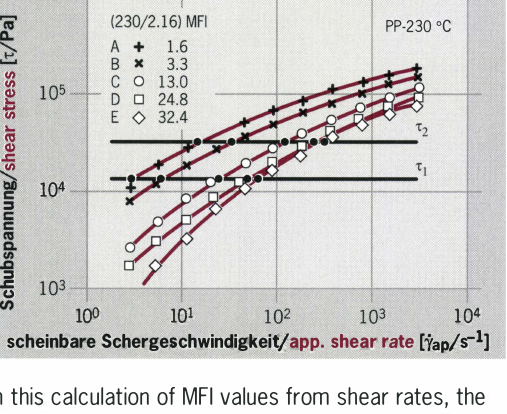
Fig. 6: Shear stress functions �{y} of various polypropylene melts and lines of constant shear stress �1 = 1 Pa and �2 = 3.0 . 104 . 3 · 104